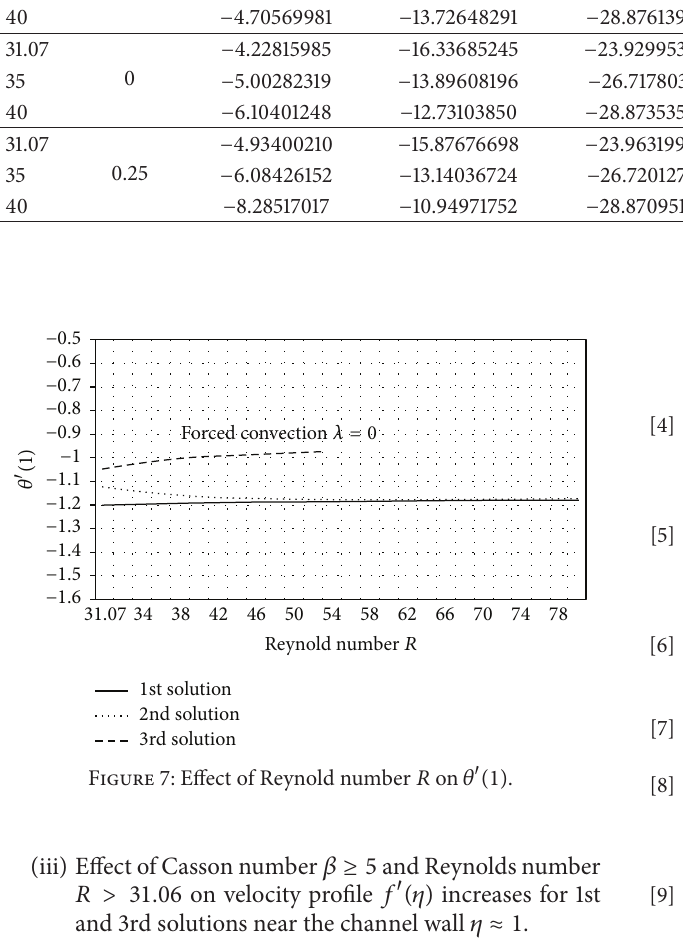
(iii) Effect of Casson number 𝛽 ≥ 5 and Reynolds number 𝑅 > 31.06 on velocity profile 𝑓 󸀠 (𝜂) increases for 1st and 3rd solutions near the channel wall 𝜂 ≈ 1 . (iv) Effect of Reynold number 𝑅 on skin friction 𝑓 󸀠󸀠 (1) and 𝜃 󸀠 (1) is the same for assisting flow 𝜆 > 0 and opposing flow 𝜆 < 0